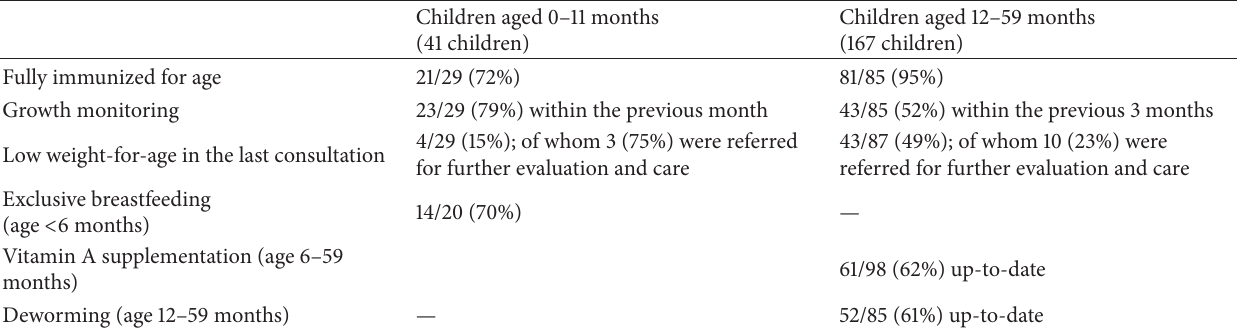
Table 4: Healthcare for children under five years of age (including 4 CAG and 204 non-CAG